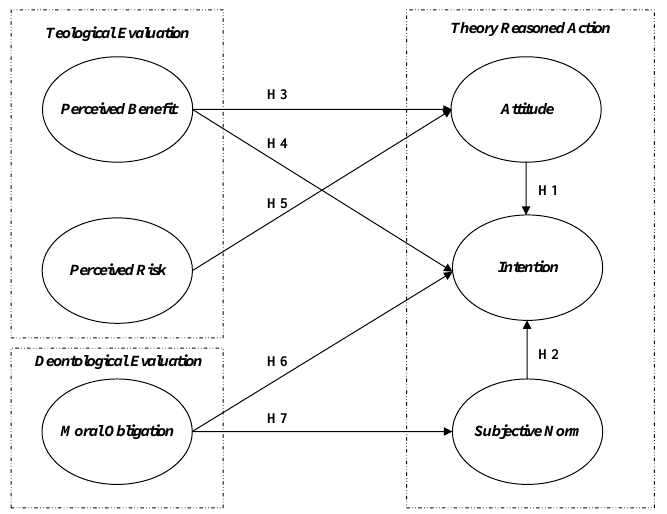
Fig. 1. Research model; Source :